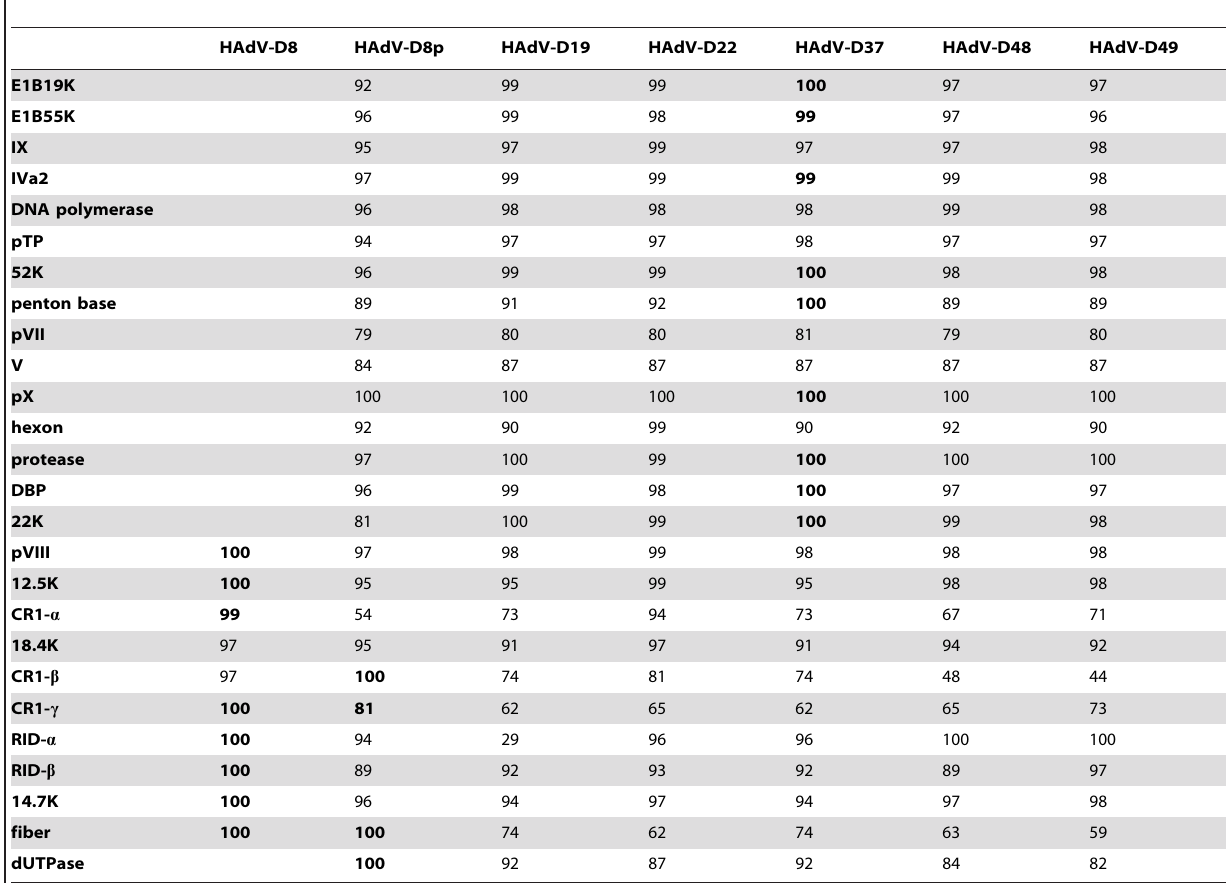
Table 2. Percent identities of selected amino acid sequences of HAdV-D53 proteins and their homologs.